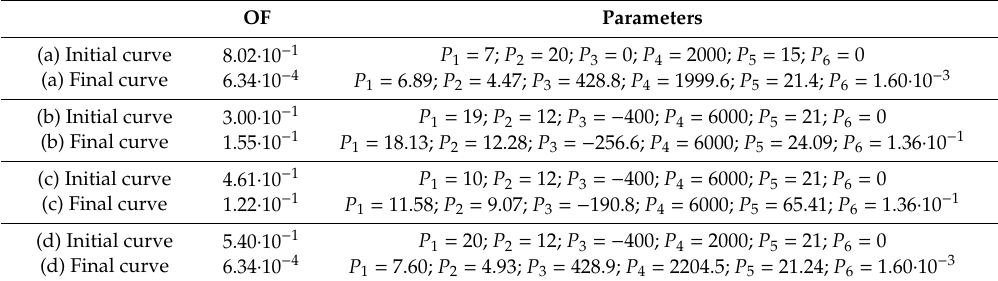
Figure 3. Final curves obtained with Levenberg–Marquardt algorithm (LM) for curve left part of the measured major hysteresis loop (SML) using four di ff erent initial curves: ( a ) The correct result; ( b ) An incorrect result; ( c ) An incorrect result; ( d ) The correct result. Table 1. The OF and parameters’ values calculated with LM and used for both the initial and final analytical curves presented in Figure 3.